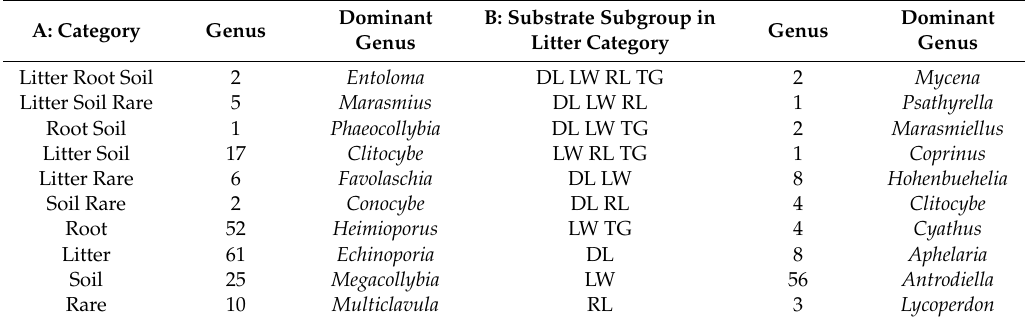
Figure 3. Venn analysis of substrate utilization of each macrofungal genera collected in the GMS by ( A ) substrate category and ( B ) substrate subgroup in the category of litter. Each substrate is represented by a single color with the number of genera present in each, while the number in overlapping colors represents the count of macrofungi present in the multiple substrates whose colors overlap there. For help with substrate subgroup identification, see Table S1. Table 3. Substrate category ( A ) and substrate subgroup in litter category ( B ). Amount of genera recorded in ( A ) and ( B ), and dominant genera in ( A ) and ( B